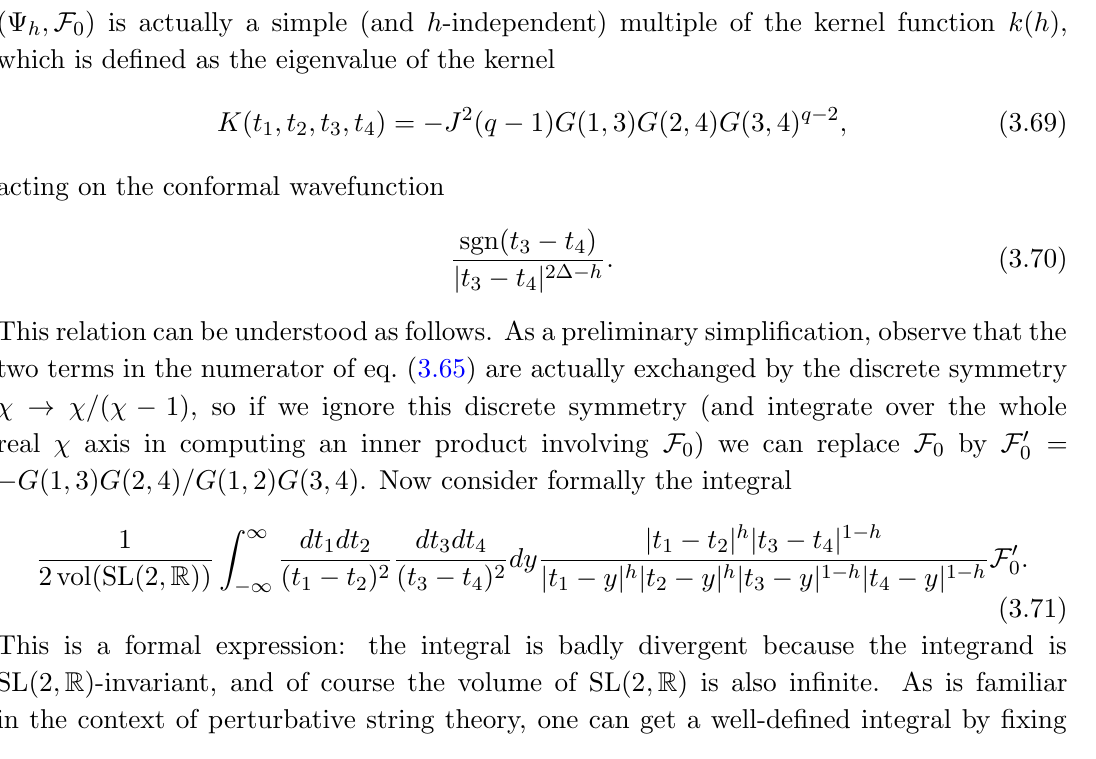
12 34 subtracted out). The lines represent exact two-point h ih i